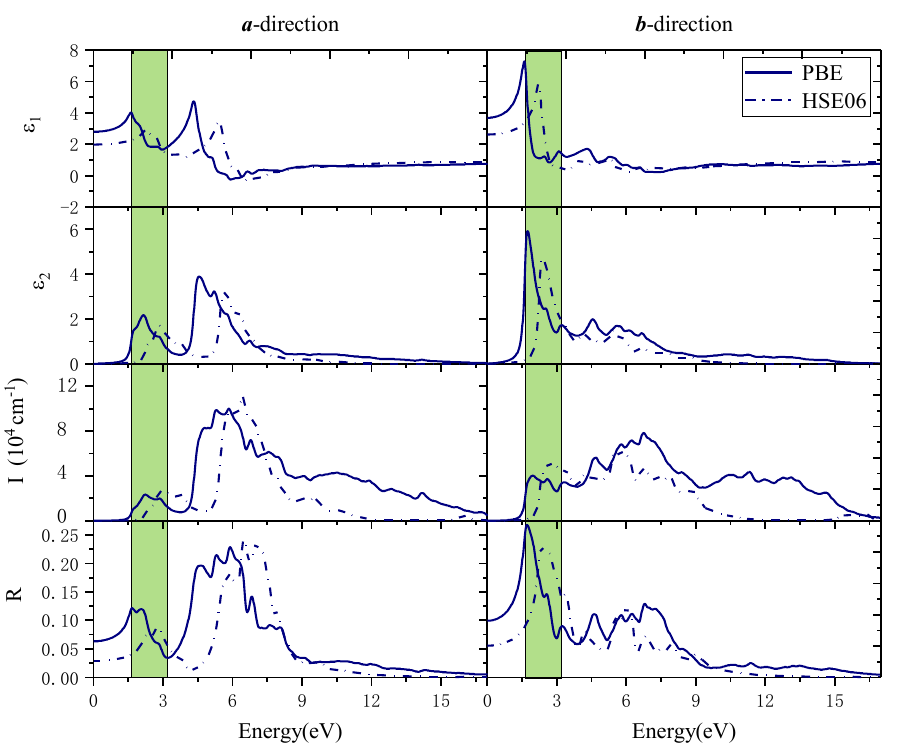
Figure 5. The calculated real part of the dielectric function ( ε 1 ), the imaginary part of the dielectric function ( ε 2 ) absorption coefficient (I), and reflection coefficient (R) in the a -direction and b -direction using the PBE method (solid line) and HSE06 method (dotted line). The area in the shaded area corresponds to the visible light region.